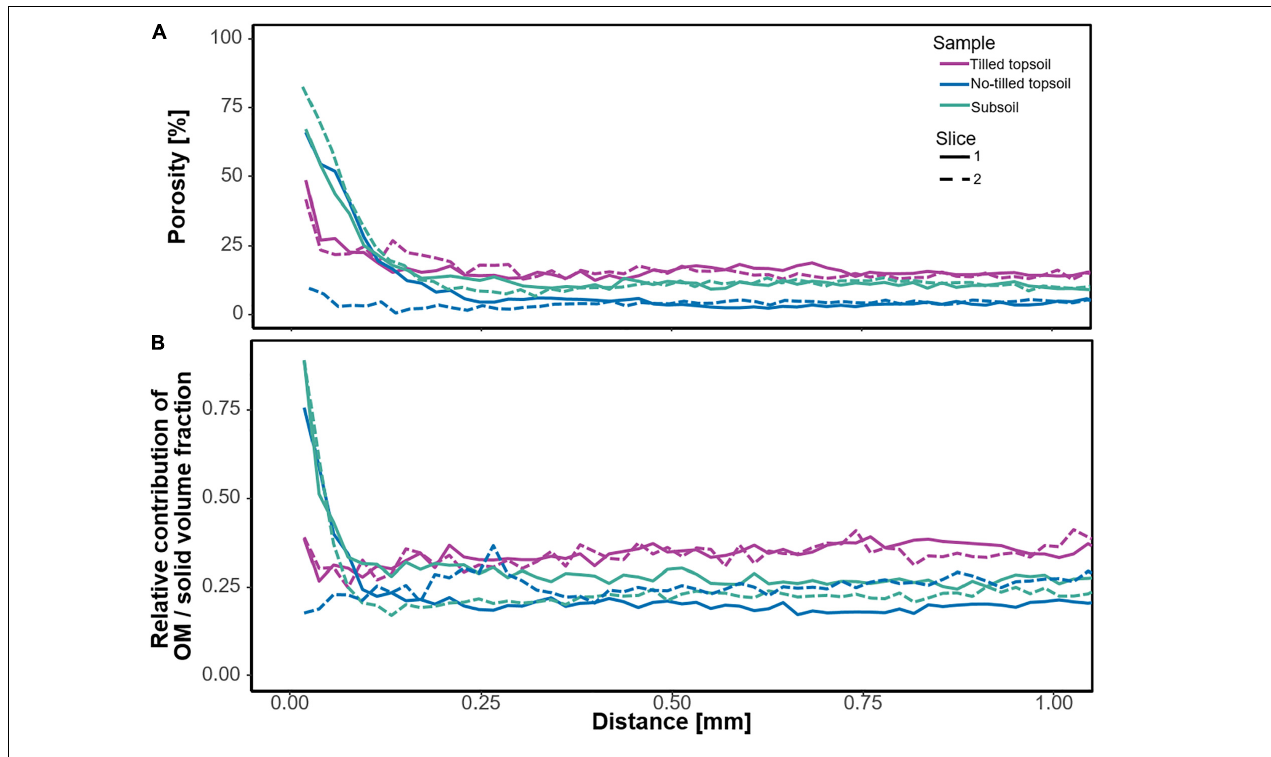
FIGURE 6 | (A) Porosity and (B) spectral intensity of OM normalized by the solid volume fraction, as a function of the 3D Euclidean distance to biopores. The normalization made it possible to account for the density shifts around the biopores as visible in (A)